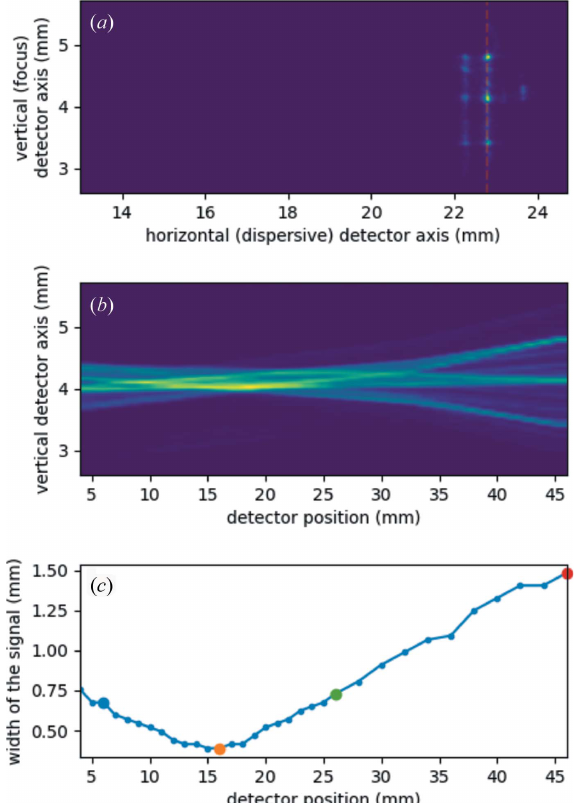
Figure 8 ( a ) Cut of the total raw detector image recording the Cu K (cid:2) XES spectrum of a polycapillary Cu anode X-ray tube via the conical-analyzer- based von Ha´mos spectrometer. The horizontal axis corresponds to the dispersive direction of the spectrometer, the vertical axis to the focusing direction. Intensity units are untreated ADU. The X-ray tube was operated at 50 kV and 1 mA, acquisition time was 10 s. ( b ) Effect of sliding the detector along the line connecting the detector and the source (‘detector position’ axis) on the focal size of the K (cid:2) 1 peak. The latter is extracted from each single detector image by choosing the column with the highest intensity [an example of the chosen data column is represented by the orange line in ( a )]. ( c ) Width of the focus of the chosen K (cid:2) 1 peak column as a function of detector position.